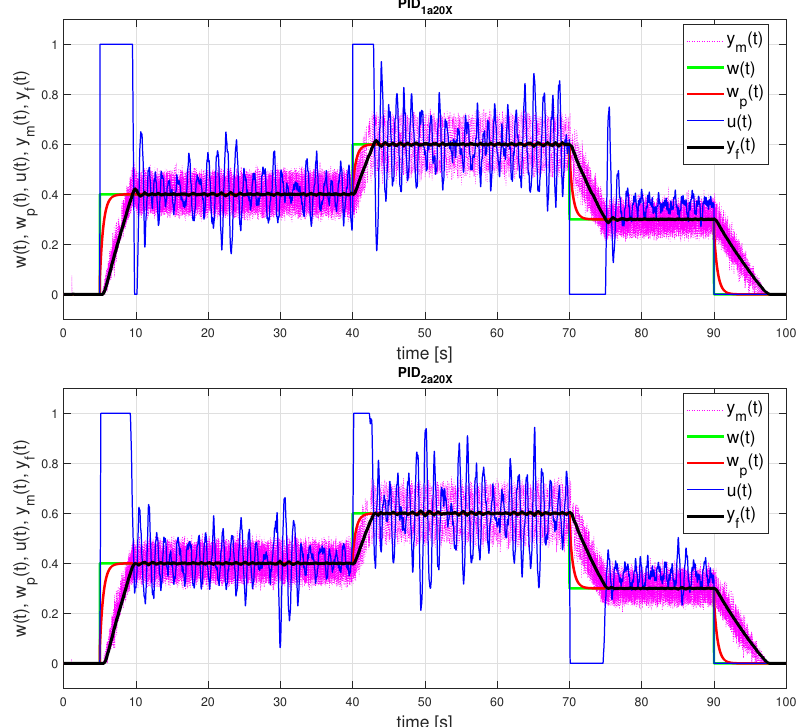
Figure 13. PID control: setpoint responses corresponding to FOTD20X approximation (50) achieved with t a = 20 for a modified grid of parameters (41) with two times finer steps for T and K s and the controller parameters